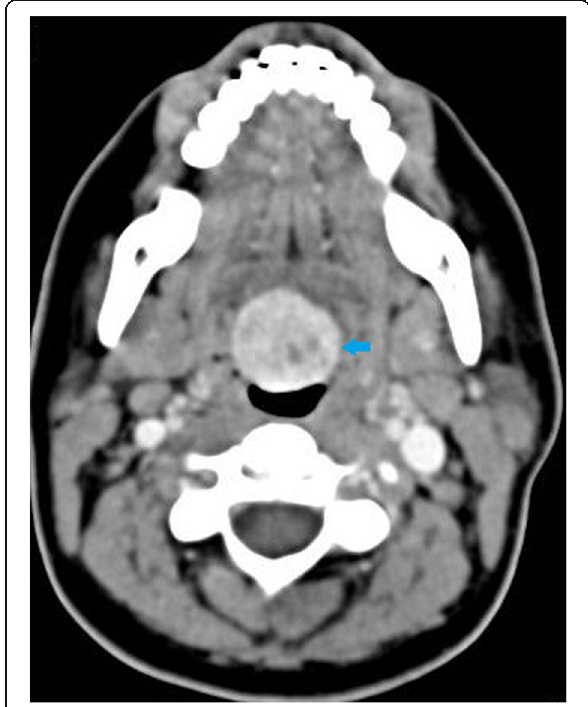
Fig. 1 Head and neck contrast-enhanced axial computed tomographic scan showing a hyperdense soft tissue density in the midline at the base of the tongue